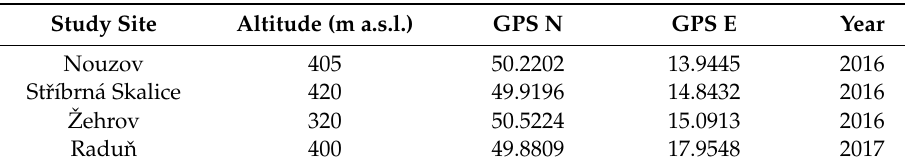
Table 2. Study sites for experiment 4.